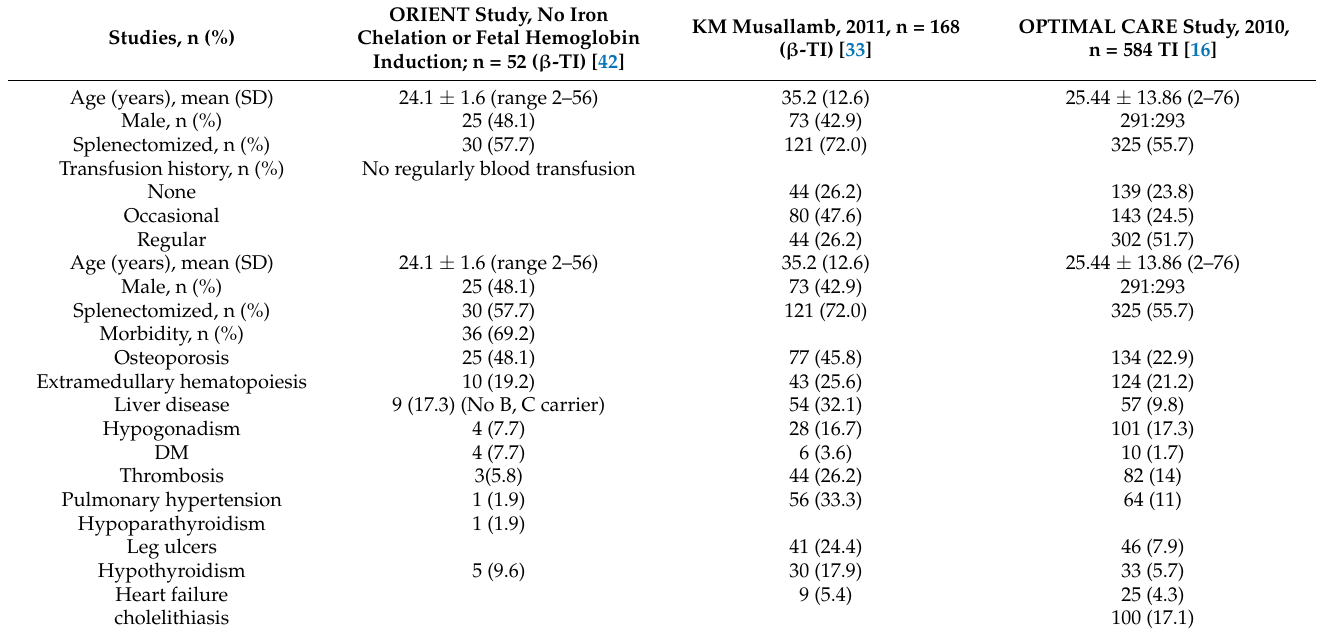
Table 2. Morbidities of thalassemia